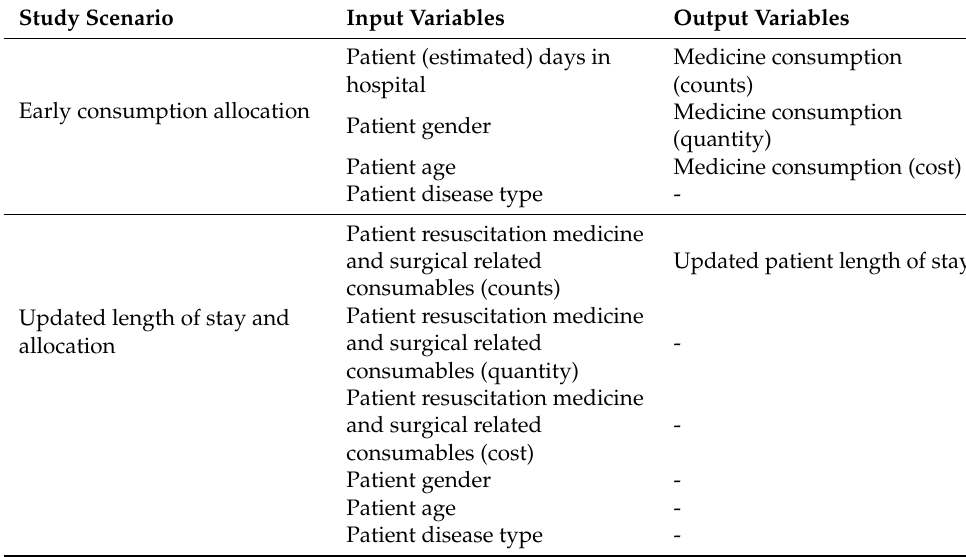
Table 1. Two forecasting models for estimating patient medical